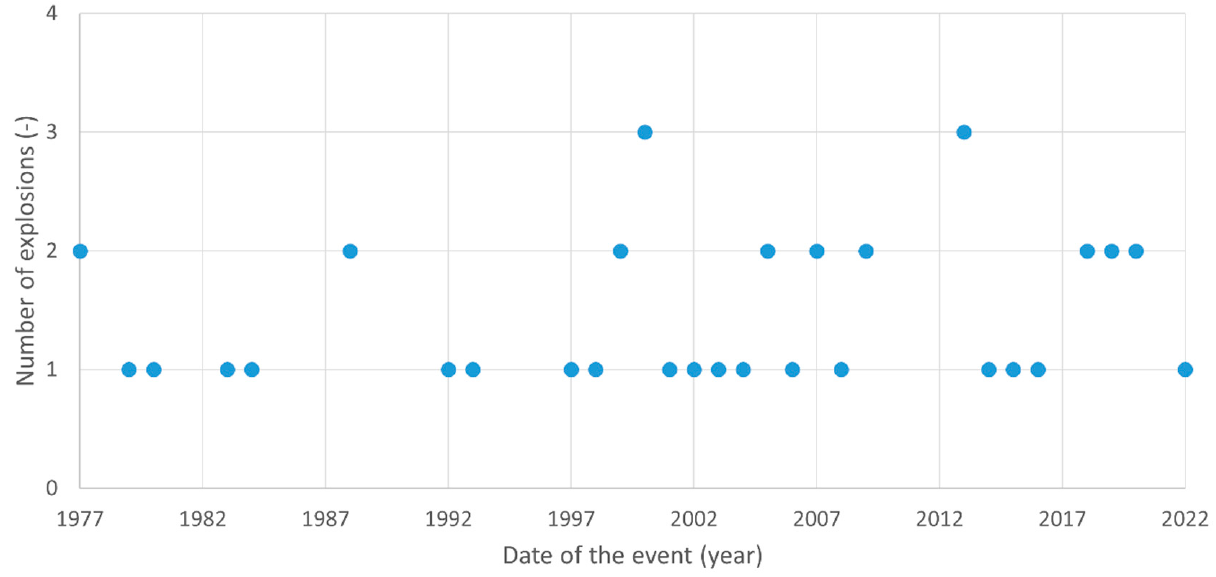
Figure 6. Number of explosions of marine main engine turbochargers in the individual years of the 1977–2022 period.